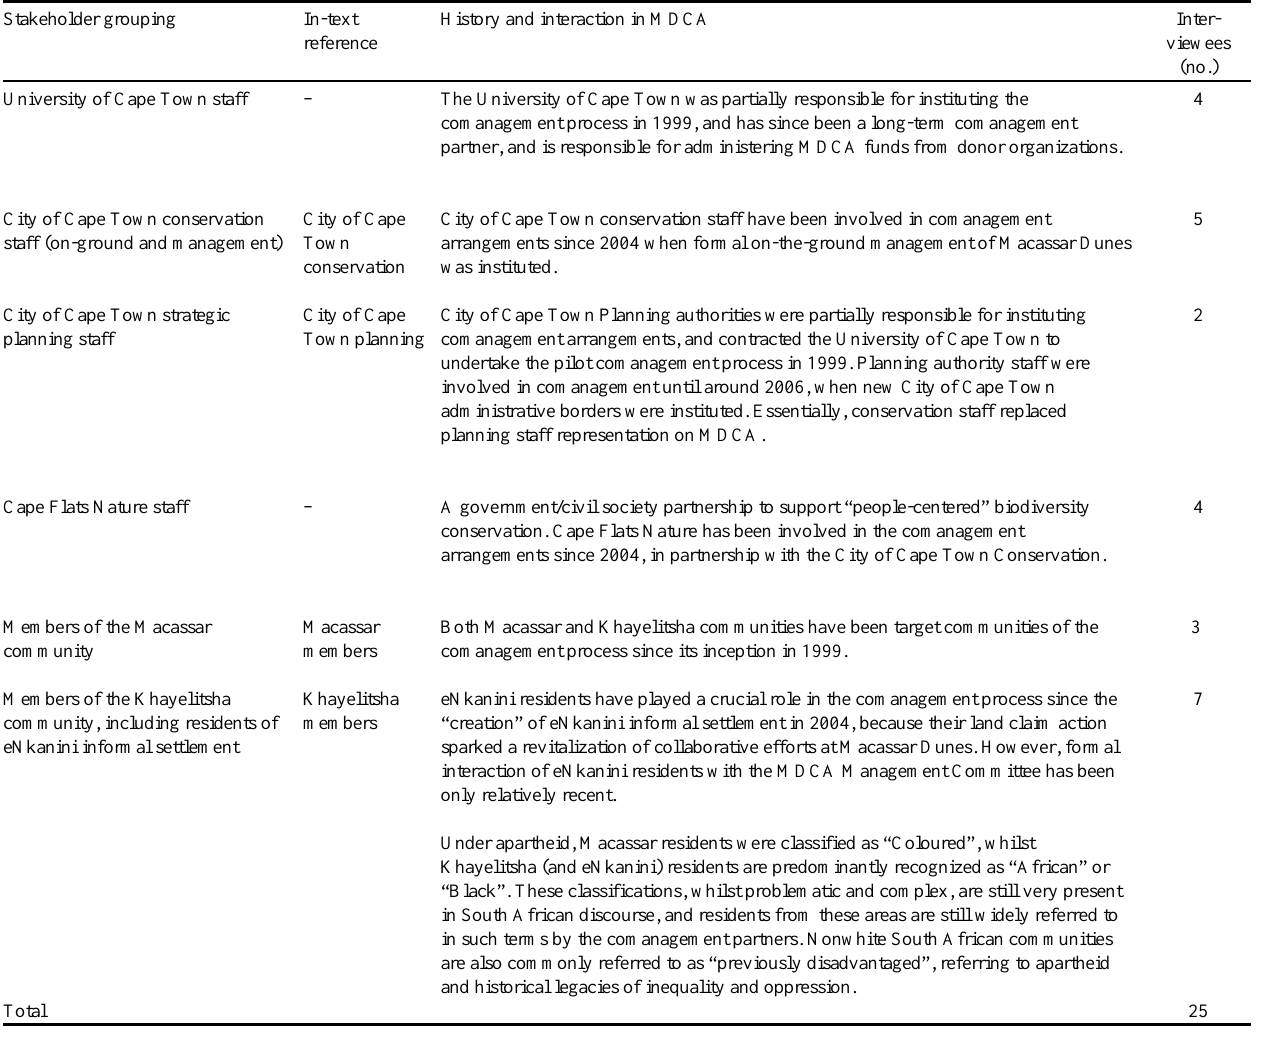
Table 1 . The six stakeholder groupings identified during the course of the interviews. Stakeholder